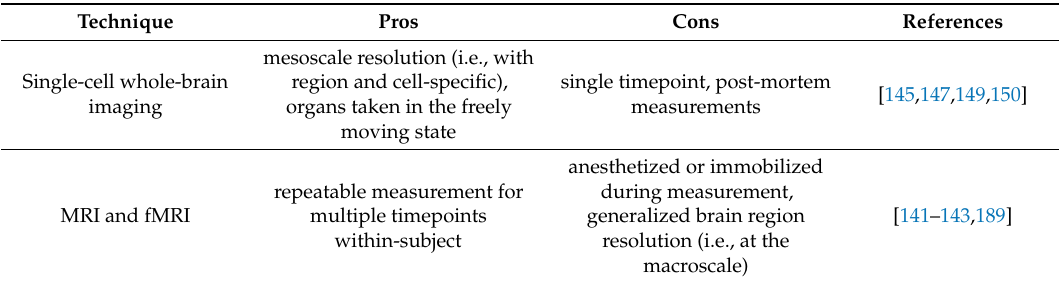
Table 3. Pros and cons of imaging techniques used for neural network analysis of functional and structural brain